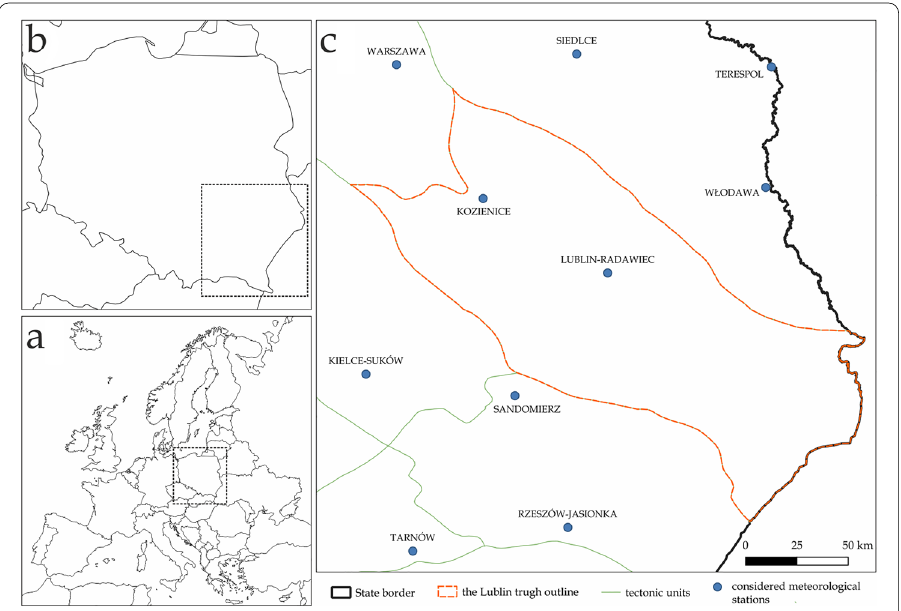
Fig. 1 Location of the Lublin trough (SE Poland) and available meteorological